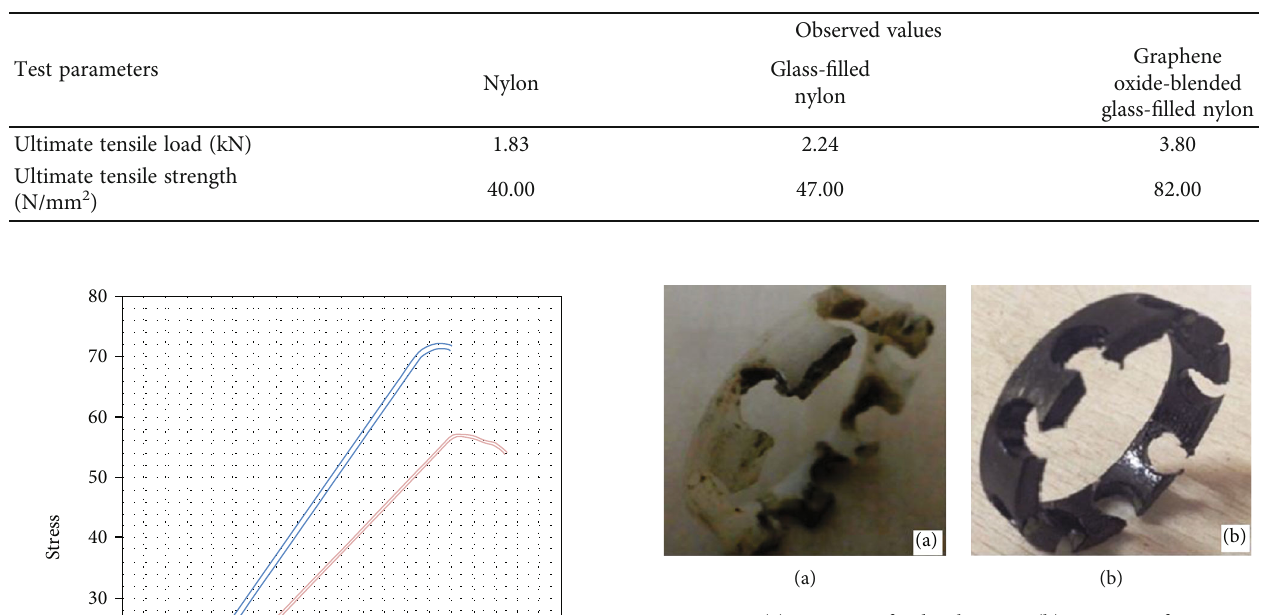
Figure 12: (a) Retainer of nylon bearing. (b) Retainer of GO-GFN